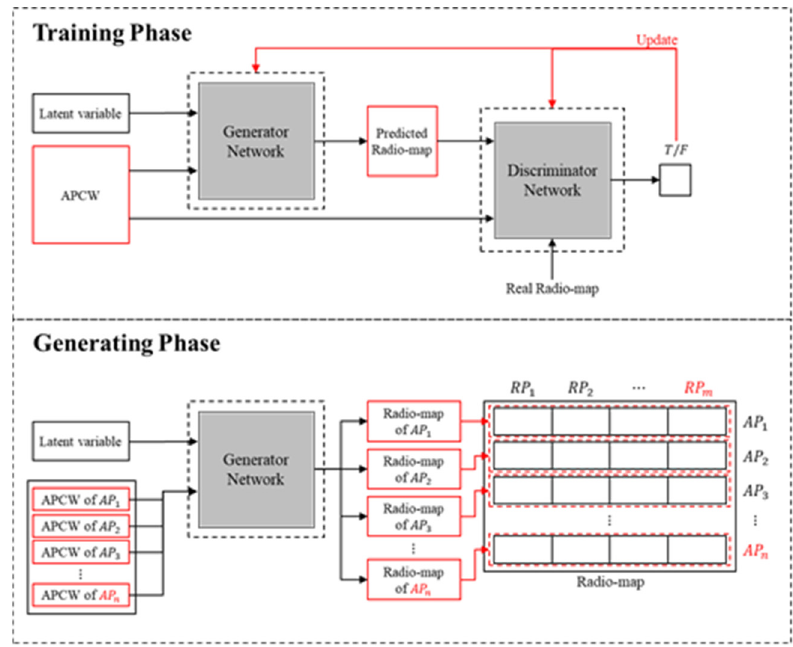
Figure 3. Architecture of the APCW-based RGN.